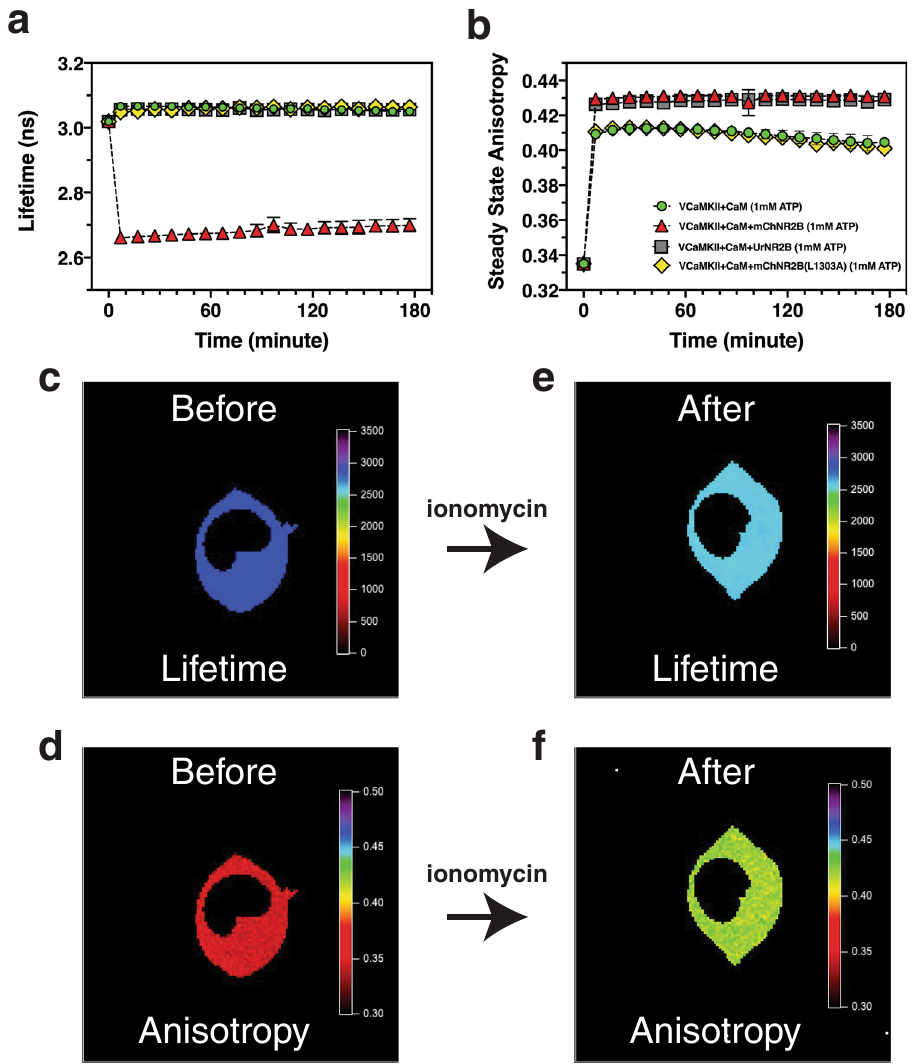
Fig.3|Timecourseofbinary-FRETofCaMKIIactivationandNR2Bassociation. Changes in the in vitro mVenus fl uorescence lifetime ( a ) or steady-state aniso- tropy( b )when V-CaMKII was activatedalone(green circles),orinthepresenceof mCherry-tagged NR2B binding fragment (red triangles), mUranus-tagged NR2B binding fragment (gray squares), or with mCherry-tagged mutant NR2B(L1303A) binding fragment (yellow diamonds). Each point is mean±SD, n =4 independent samples with two replicates per sample. Representative anisotropy and lifetime